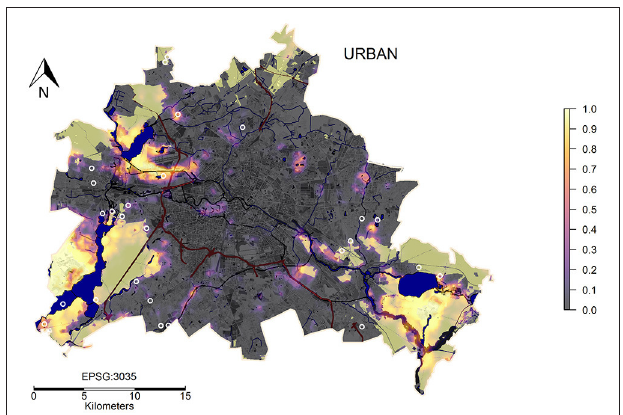
FIGURE 5 | Prediction map and urban structure A prediction map ( Figure 4B ) for urban wild boar space use (transparency 50%) was overlapped with a map showing sealed surfaces. In addition, waterbodies were displayed in blue. Areas of urban forestry departments, where wild boar presence is known, was stained light green. The white circles are locations where wild boar were hunted by city hunters (for more details see Stillfried et al., 2017a) and show presence of wild boar outside the forest